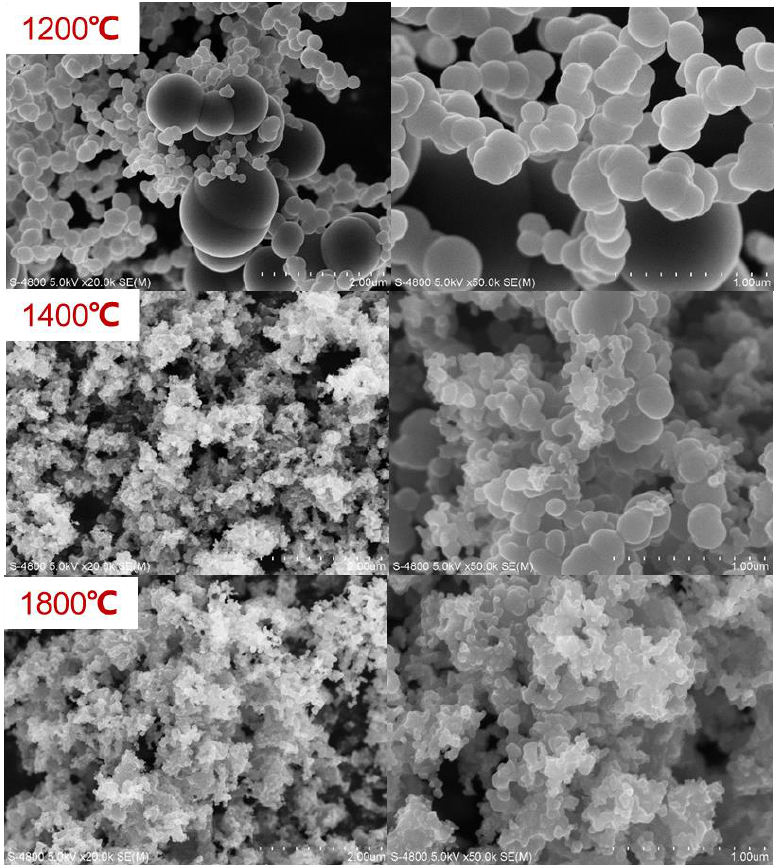
Figure 6. SEM images of carbon black.